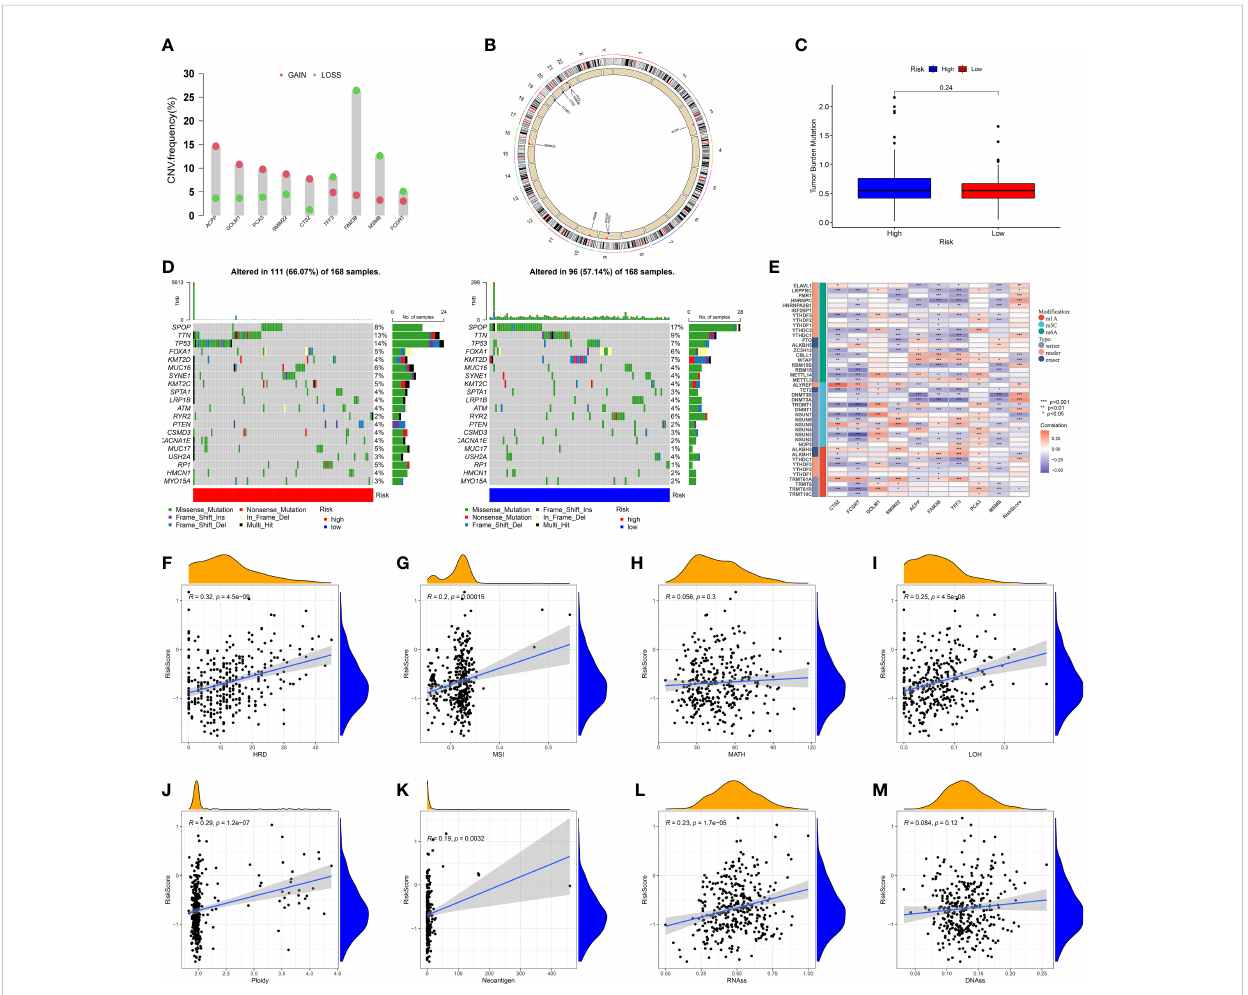
FIGURE 9 Genomic heterogeneity and tumor stemness based on MRMGPS. (A) CNV of the 9 MRMGPS-based genes. (B) Chromosomal location of CNV of MRMGPS-based genes. (C) Comparison of TMB between the low- and high-risk groups. (D) Waterfall plot displaying gene mutations in high- and low-risk groups. (E – M) Correlation between risk score and RNA-modi fi ed genes (E) , HDR (F) , MSI (G) , MATH (H) , LOH (I) , Ploidy (J) , Neoantigen (K) , RNAss (L) , DNAss (M) . CNV, copy number variation; TMB, tumor mutational burden; HRD, homologous recombination defect; MSI, microsatellite instability; MATH, mutant-allele tumor heterogeneity; LOH, loss of heterozygosity; RNAss, RNA-based stemness scores; DNAss, DNA-methylation- based stemness